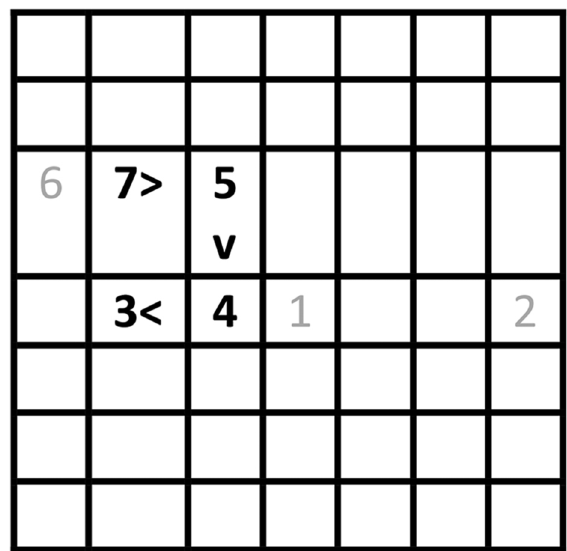
Fig. 3. A 7 by 7 Latin square with superimposed greater-than or smaller-than